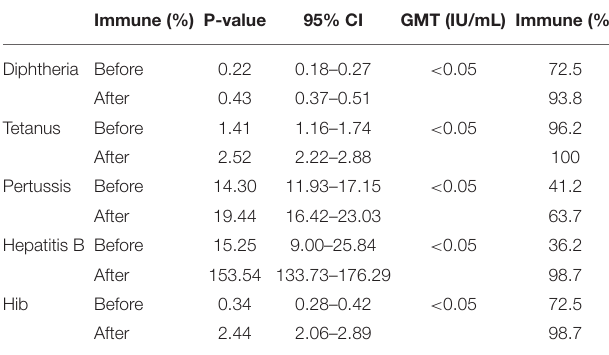
TABLE 2 | The GMT of Pentavalent vaccine components before and after the